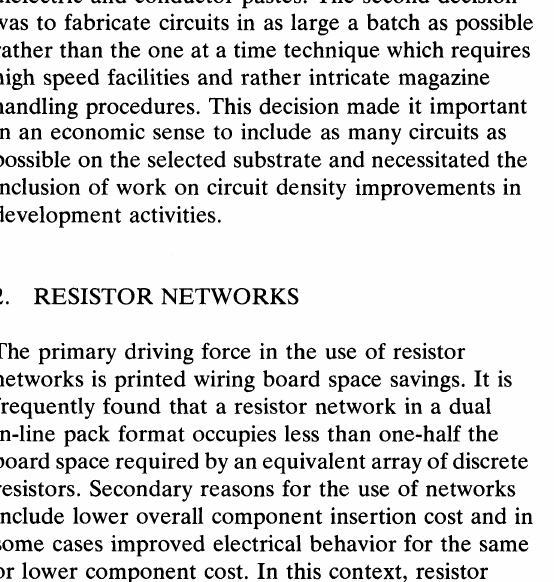
FIGURE Normalized resistance vs. resistor length for some Dupont 1400 series resistor materials.